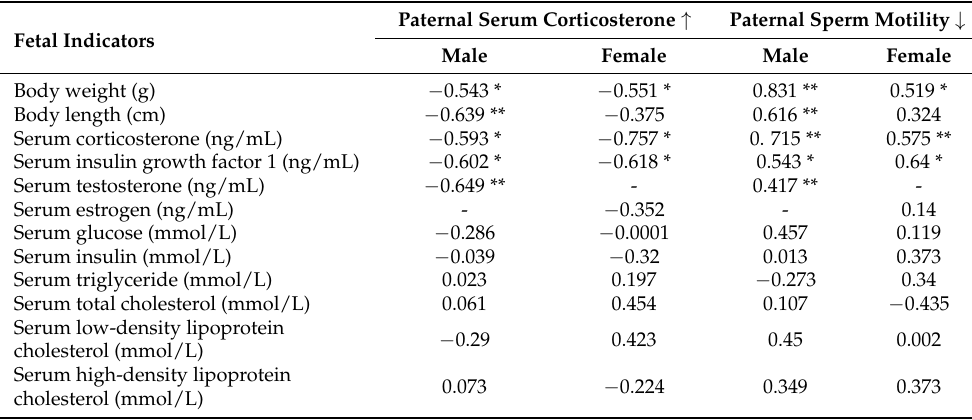
Table 2. Correlation analyses among paternal serum corticosterone/sperm mobility and fetal physical/multi-organ development in PME groups ( n =